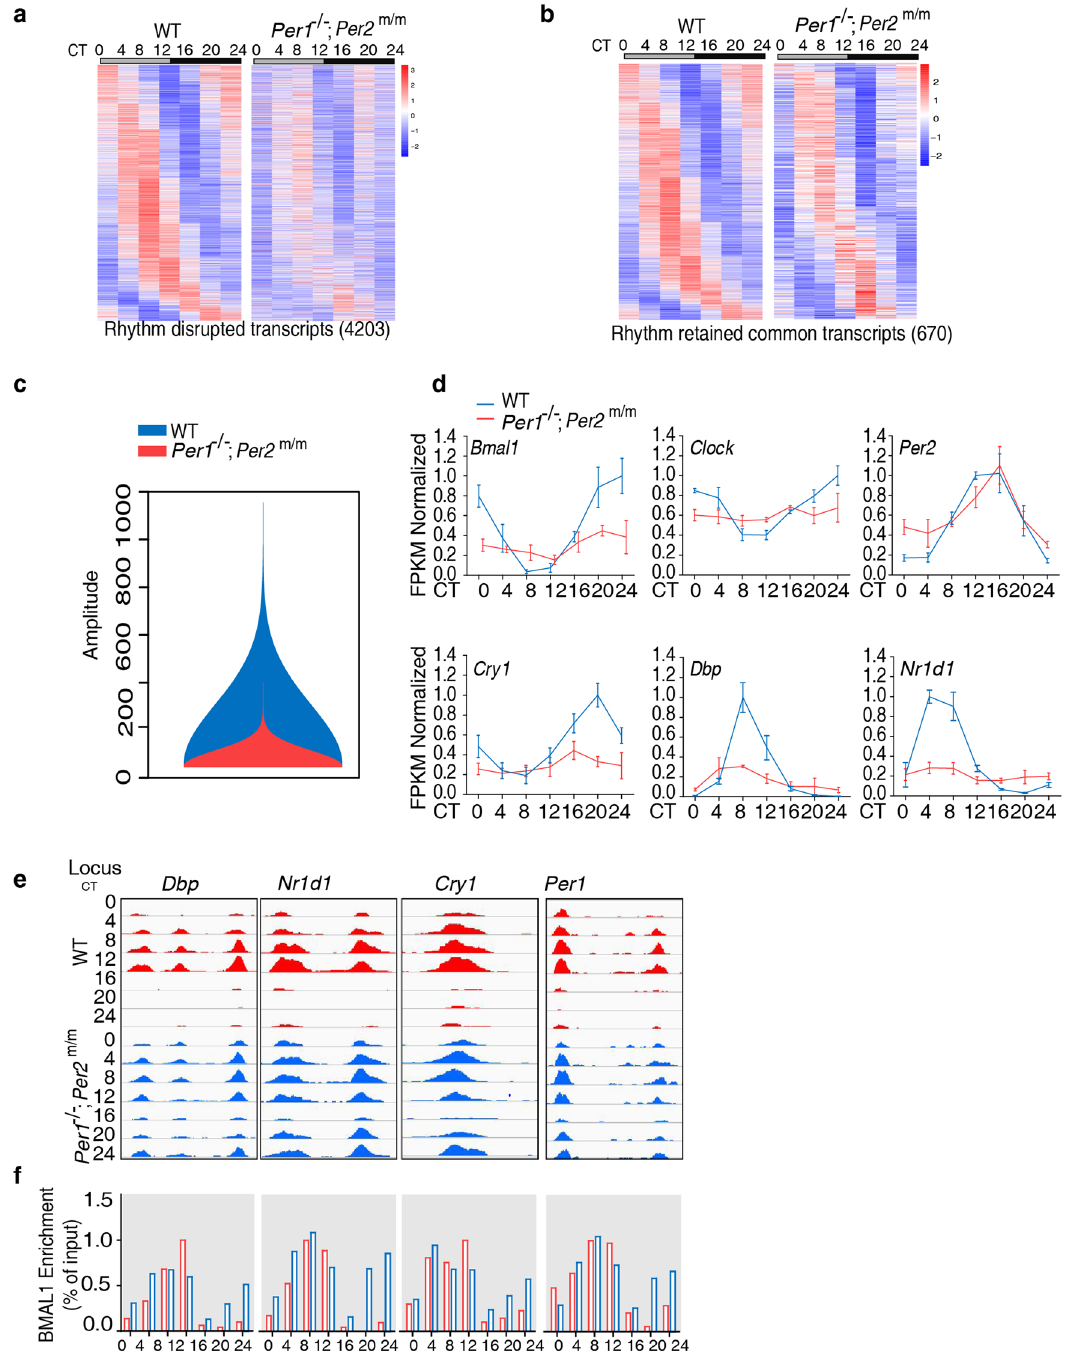
Fig. 6 Disruption of CK1 δ -PER interaction impairs robust rhythmic gene expression and removal of CLOCK-BMAL1 complex from E-boxes during subjective night. a Heatmap of transcript levels of the identi fi ed 4203 rhythmic genes in the WT and the corresponding genes in the Per1 − / − ; Per2 m/m mice at the indicated circadian time points. RNA-seq was performed using liver tissue collected at the indicated time points ( n = 3 per time point). The color bar indicates the scale used to show the expression levels of transcripts normalized to Z-scores. Rhythmic expressed genes were identi fi ed by meta2d function in MetaCycle with adjusted p < 0.05, period 24h. b Heatmap of common 670 rhythmic genes in the WT and Per1 − / − ; Per2 m/m mice (MetaCycle package, P < 0.05). The color bar indicates the scale used to show the expression of transcripts across seven time points, with expression normalized to Z-scores. c Violin plot comparing the amplitudes of common rhythmic genes in the WT and Per1 − / − ; Per2 m/m mice. The relative amplitudes of the 670 common rhythmic genes in the WT and Per1 − / − ; Per2 m/m mice were obtained from MetaCycle package and the violin plot was generated using R package vioplot (https://cran.r-project.org/web/packages/vioplot/vioplot.pdf). d Rhythmic transcript levels of selected clock genes in the WT and Per1 − / − ; Per2 m/m mice determined by RNA-seq. Data are represented as mean ±SD, n = 3. e BMAL1 ChIP-Seq results at the indicated time points and loci in the WT and Per1 − / − ; Per2 m/m mice. UCSC genome browser views of BMAL1 occupancy are shown. Each track represents the normalized ChIP-seq read coverage (wiggle plot) across regulatory regions of the indicated genes. f Quanti fi cation of relative BMAL1 levels at the indicated E-box loci at the different time points.